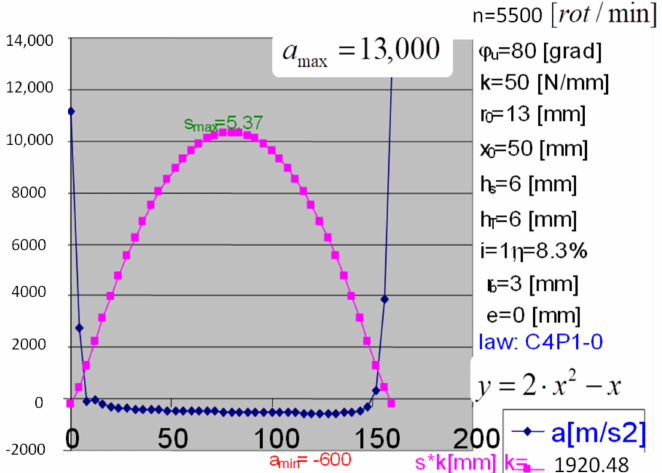
Figure 16. Dynamic analysis at module B. C4P law, n = 5500 [rot/min] ϕ u = 80 [degree], r 0 = 13 [mm], r b = 3 [mm], h T = 6